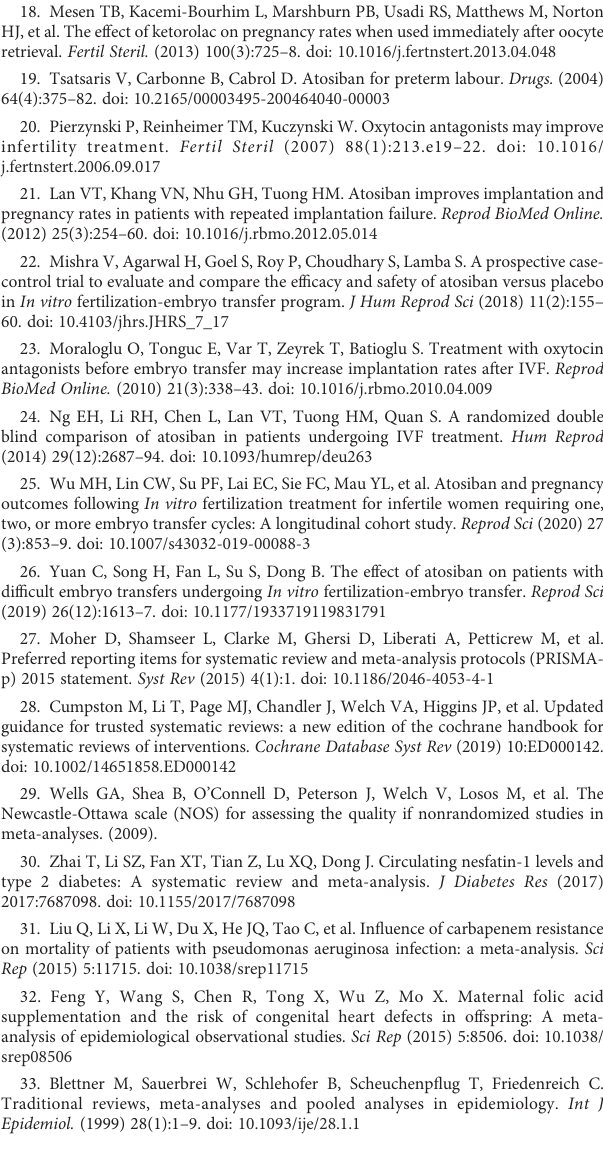
SUPPLEMENTARY FIGURE 7 Forest plots of ectopic pregnancy